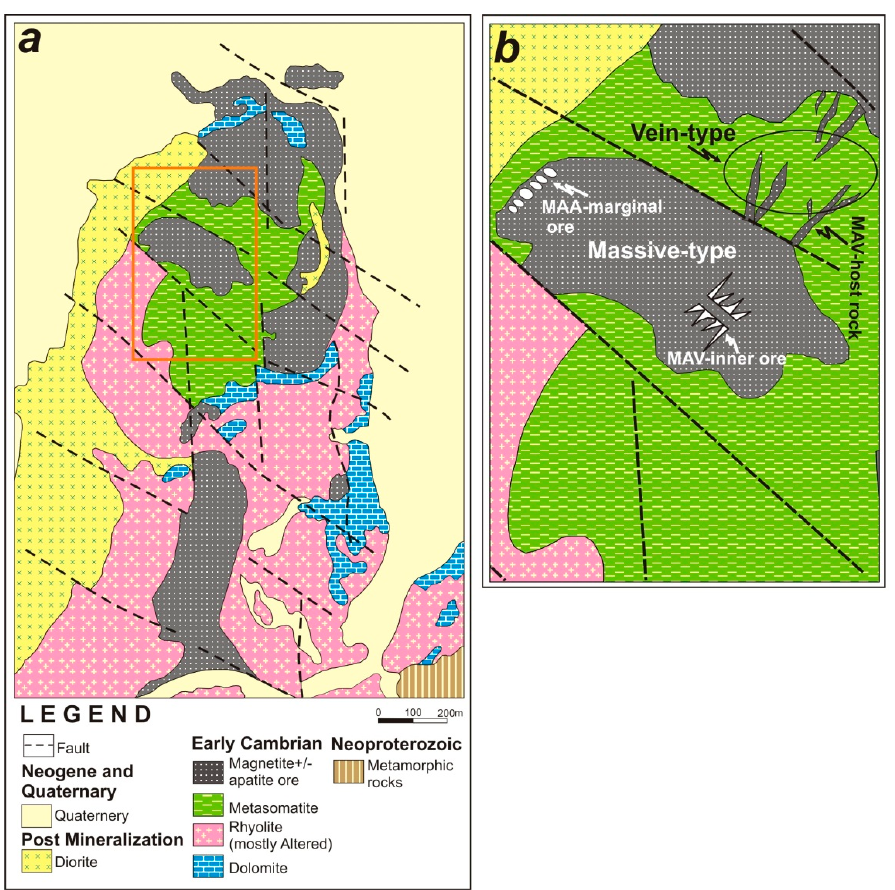
Figure 2. ( a ) Simplified geological map schematically showing the alteration types and their relationships in the Chadormalu deposit (modified from [39,40]). ( b ) Enlarged view of the square in (a) to show details of the ore types (this study). Magnetite-apatite veins in altered host rocks (MAV-host rock); Disseminated magnetite-apatite associations in the marginal parts of the main ore body (MAA-marginal ore); Magnetite-apatite veinlets in the internal parts of the main magnetite ore body (MAV-inner ore).